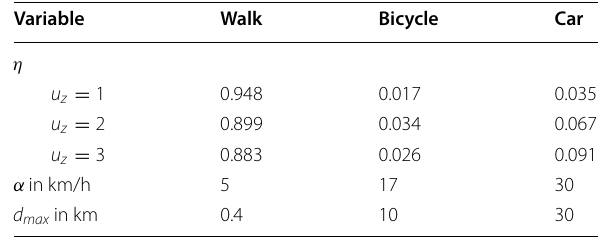
η values are derived from the calibration data set